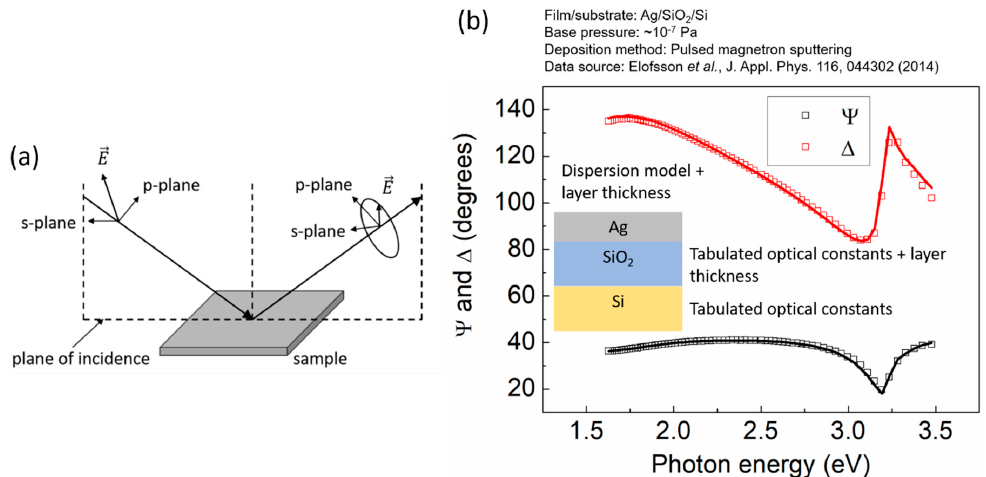
Figure 2. ( a ) Schematic illustration of the principle of spectroscopic ellipsometry. Linearly polarized light (with electric field vector E ) is reflected at sample surface. Reflection of the incident light causes change for the polarization state to elliptical. p-plane and s-plane indicate the planes that are parallel and perpendicular to the plane of incidence, respectively. By measuring the reflected intensity (i.e., intensity of the electric field E ) along the s and p directions, the ellipsometric angles Ψ and ∆ (amplitude ratio and phase shift, respectively, of the reflected light relative to the incident light) are